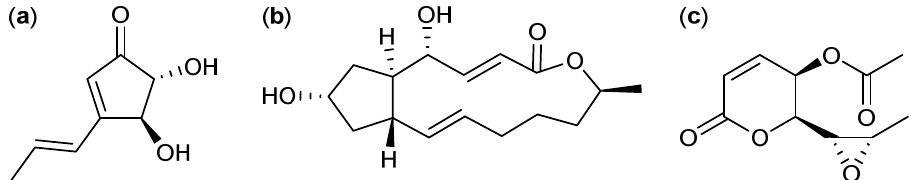
Figure 2. Small polyketides: ( a ) Terrein, ( b ) Brefeldin A, and ( c )